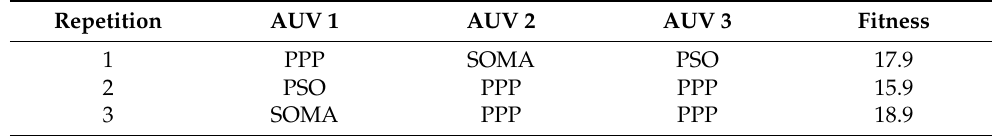
Table 5. Overview of the best combined search strategies from the three